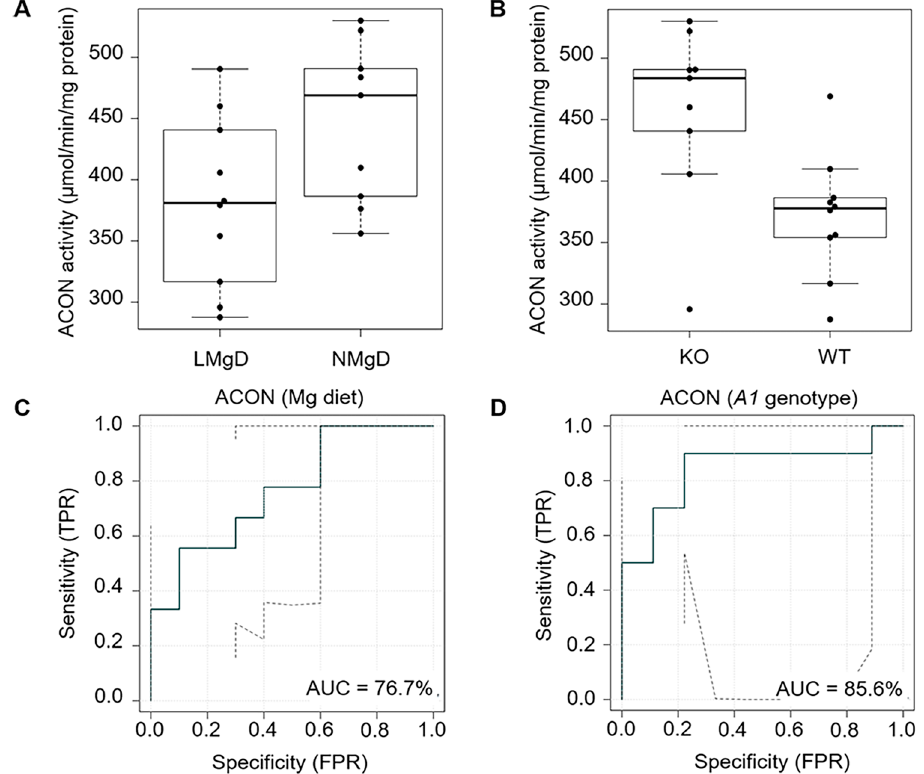
Figure 1. Impact of dietary Mg content and of Slc41a1 genotype on the activity of aconitase (ACON) in murine cardiac mitochondria. ( A ) Box-and-whisker plot overlaid with dot plot showing the influence of dietary Mg content (LMgD vs. NMgD) and ( B ) of Slc41a1 genotype ( Slc41a1 − / − vs. Slc41a1 +/+ ) on ACON activities in murine mitochondria. For both, A and B, the original, source data and corresponding medians are indicated for each group. ( C , D ) Empirical ROC (receiver operating characteristic) curves with the area under the ROC curve (AUC) for ( C ) the type of Mg diet as predictor of ACON activity and ( D ) the Slc41a1 genotype as predictor of ACON activity. Abbreviations: A1 , Slc41a1 ; FPR, false-positive rate; KO, knock-out; TPR, true-positive rate; WT, wild-type.